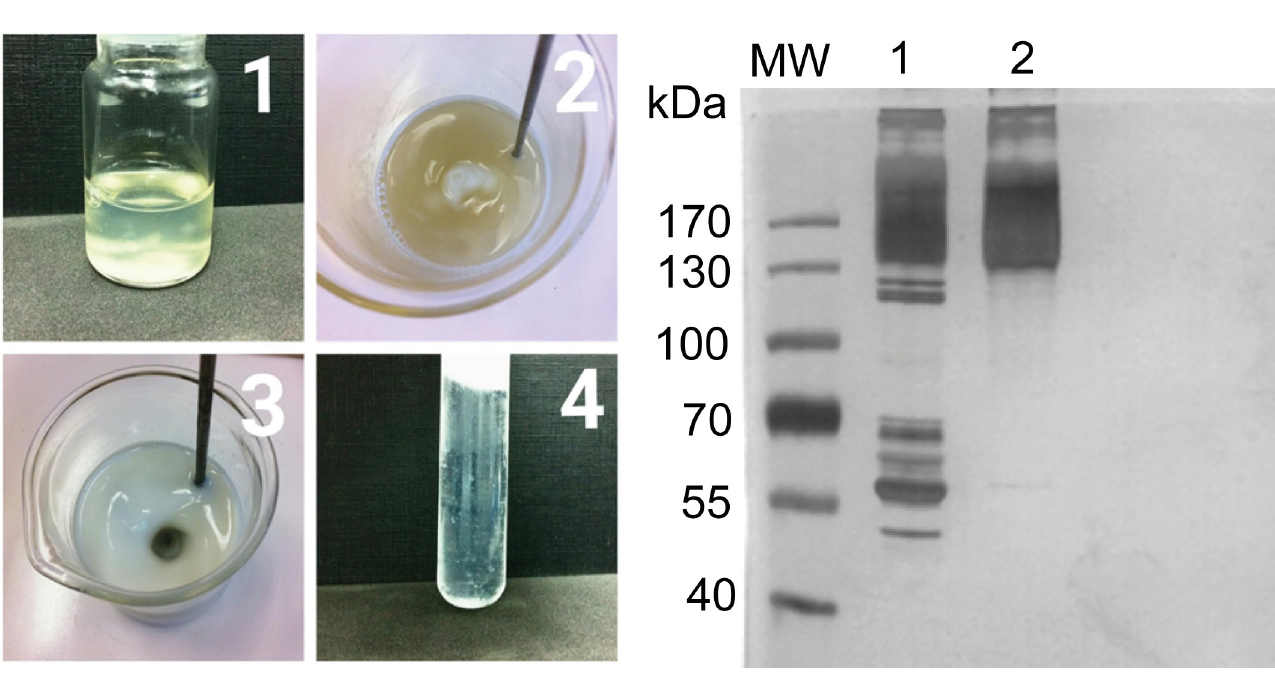
FIGURE 1 - Purification of anti-bothropic serum using caprylic acid. (A) Steps of the purification process are highlighted from 1 to 4. Where 1) represents the sample before the purification process, 2) thermocoagulation step, 3) precipitation of impurities using caprylic acid at a final concentration of 8.5 % and 4) represents the sample at the end of the process. (B) 10 % SDS-PAGE under reducing conditions of anti-bothropic serum, silver-stained. Samples were applied at 10 µg of protein content before and after purification steps to analyze the relative